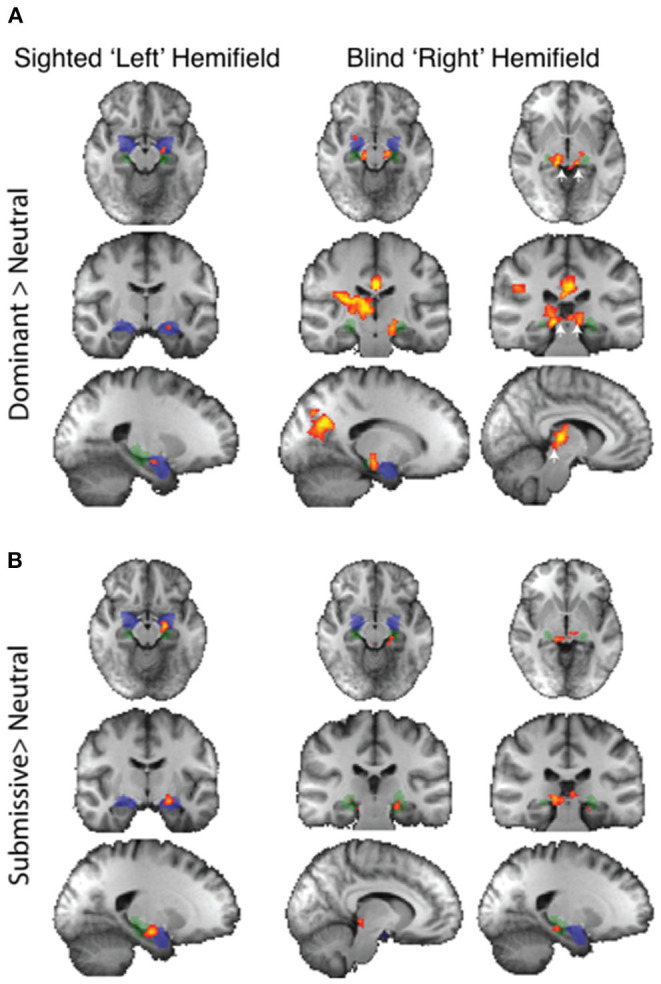
fMRI preference for dominance traits > neutral in patients with blindsight. (A) Upper panel shows activity for dominant faces > neutral in the sighted (left column) or blind fields (right two columns). (B) Lower panel shows equivalent activity for submissive faces > neutral. Fixed-effects analyses, P < 0.001 uncorrected for a priori regions of interest, elsewhere cluster corrected p < 0.01. Shaded blue areas are binarized Jülich-defined probabilistic maps of the amygdala, Jülich-defined LGN masks are green, and the superior colliculus is indicated by white arrows. Z-statistic range 2.3–4, radiological convention.